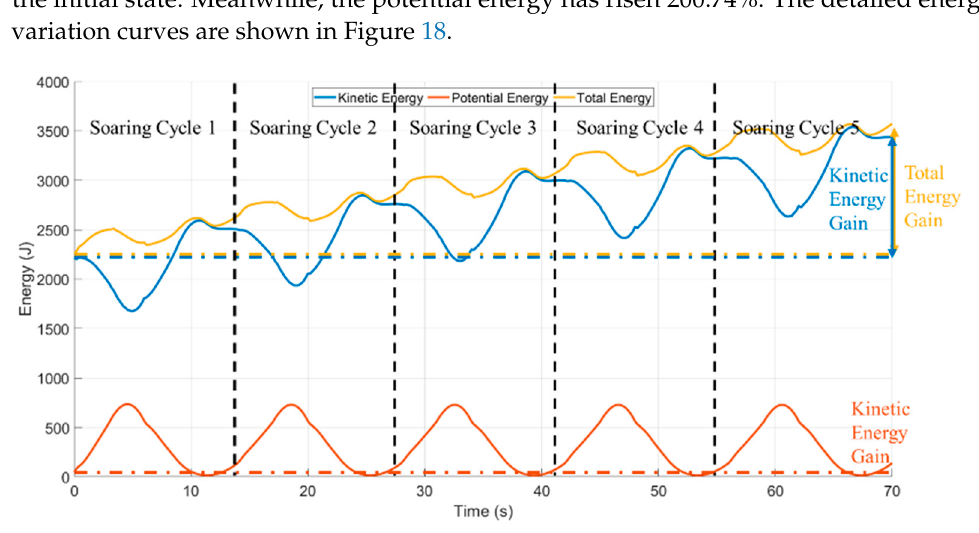
12 of 15 Table 3. Trajectory data. Initial Position (m)